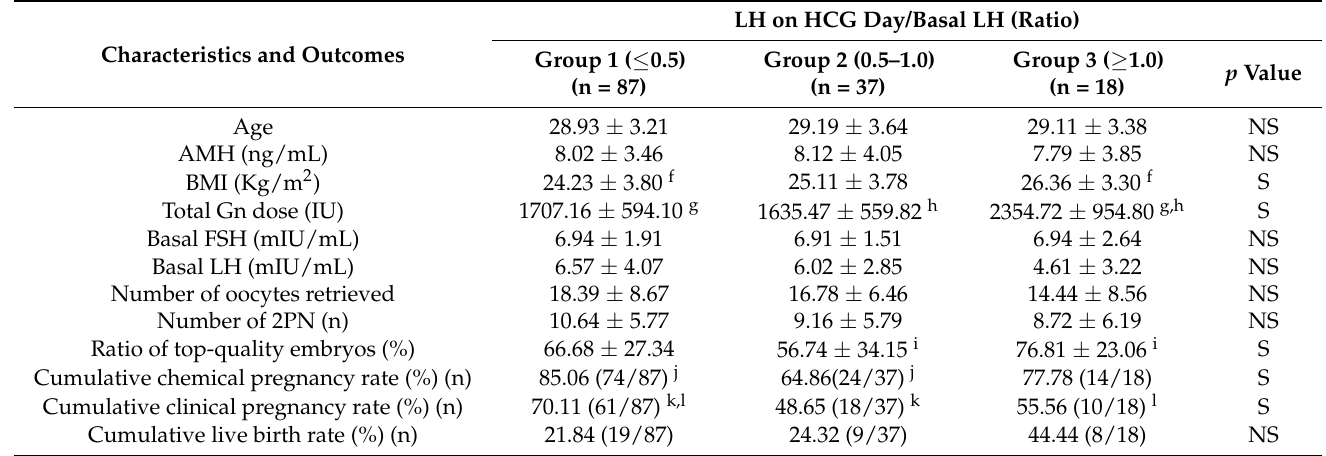
Table 4. Characteristics of patients grouped by